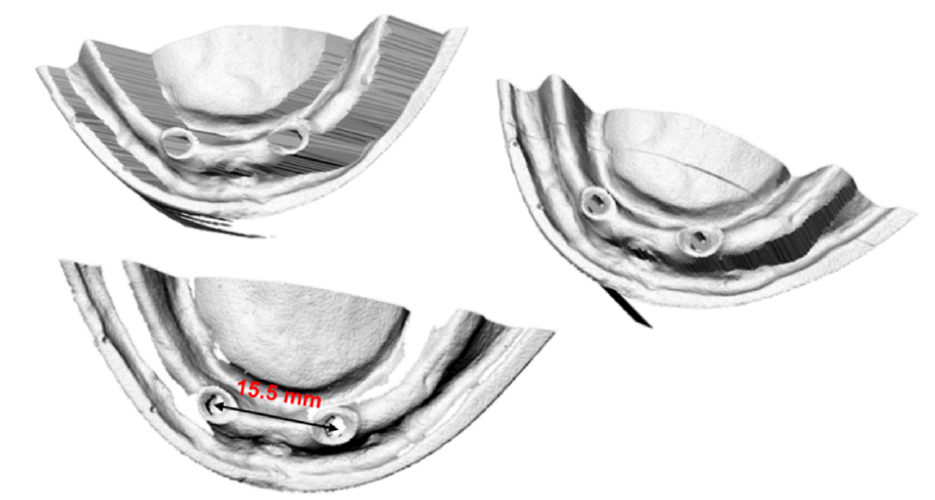
Figure 2. Visualization of measurement data obtained for the mandibular mucosa model in an LPX-600 scanner (in the real scale).